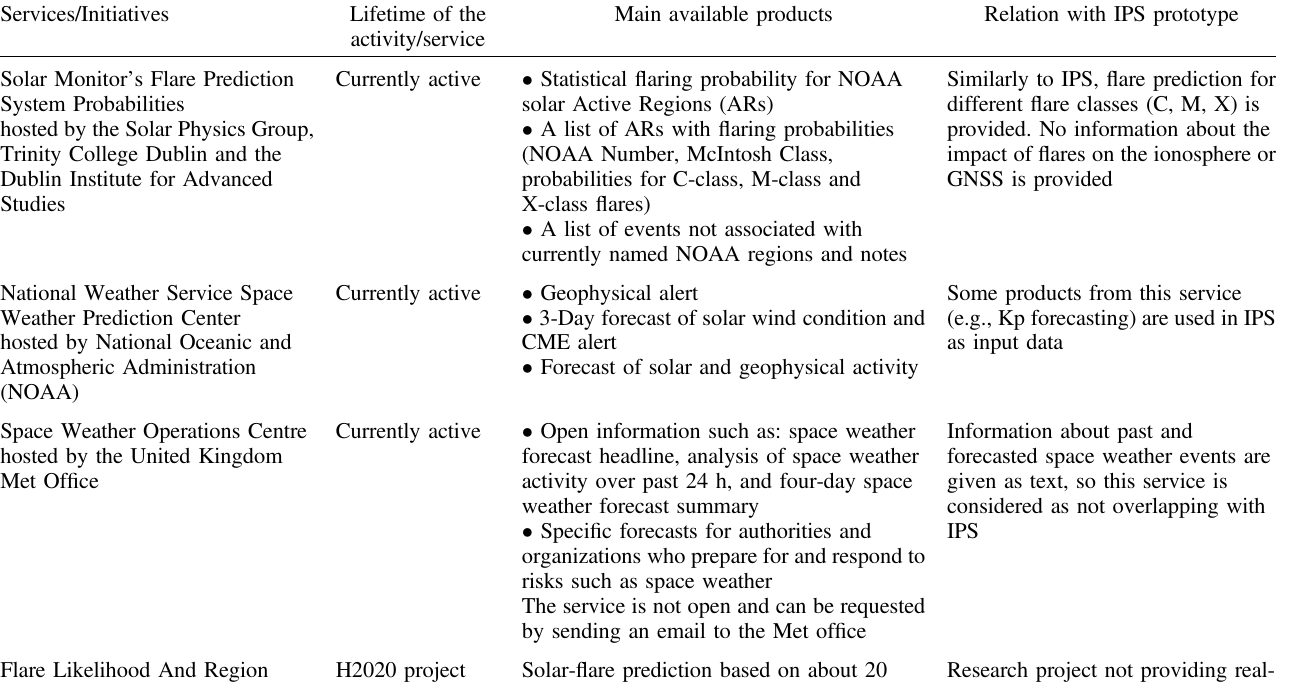
Table 1. Most important characteristics of some of the main existing parallel services/initiatives to IPS and their relation with IPS